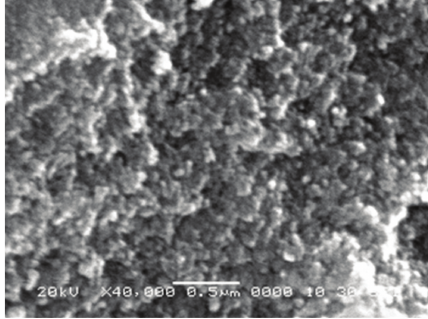
Figure 4: SEM micrographs of ZrO 2